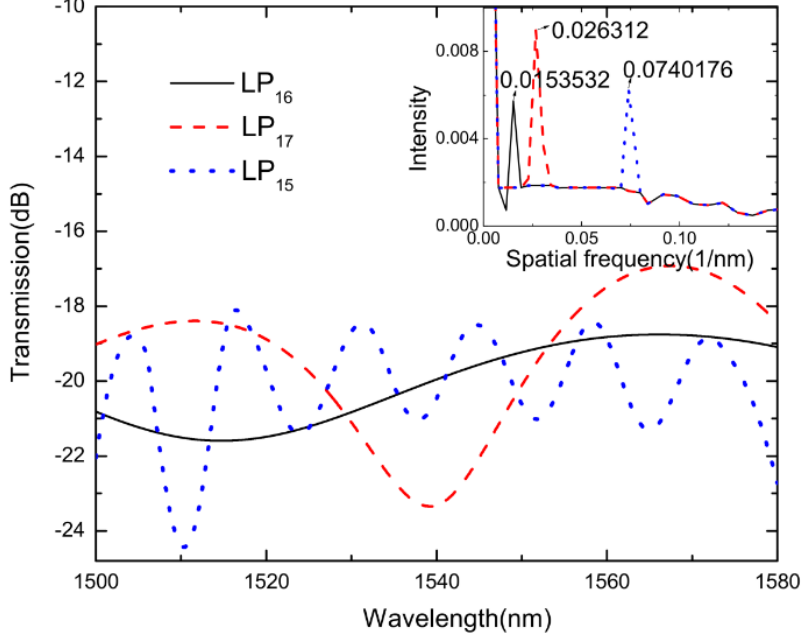
Figure 9. The derived MZI transmission spectra at different furnaces, and the inset shows the corresponding spatial frequency spectra.